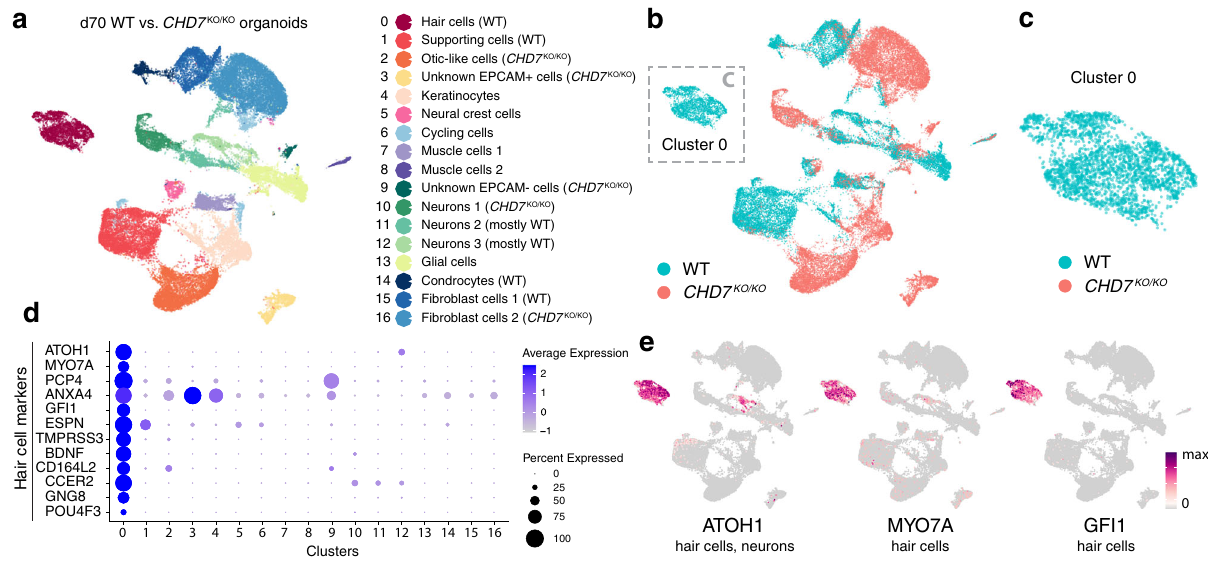
Fig. 7 | scRNA-seq of d70 WT and CHD7 KO/KO organoids suggested that CHD7 is required for hair cell generation. a – c d70 WT and CHD7 KO/KO organoids were micro-dissectedand FACS-isolated into EPCAM -positive and -negative populations. UMAP plotand cluster annotationof merged datasets of these four groups of cells were shown in ( a ), and UMAP plot grouped by genotype were shown in ( b ).